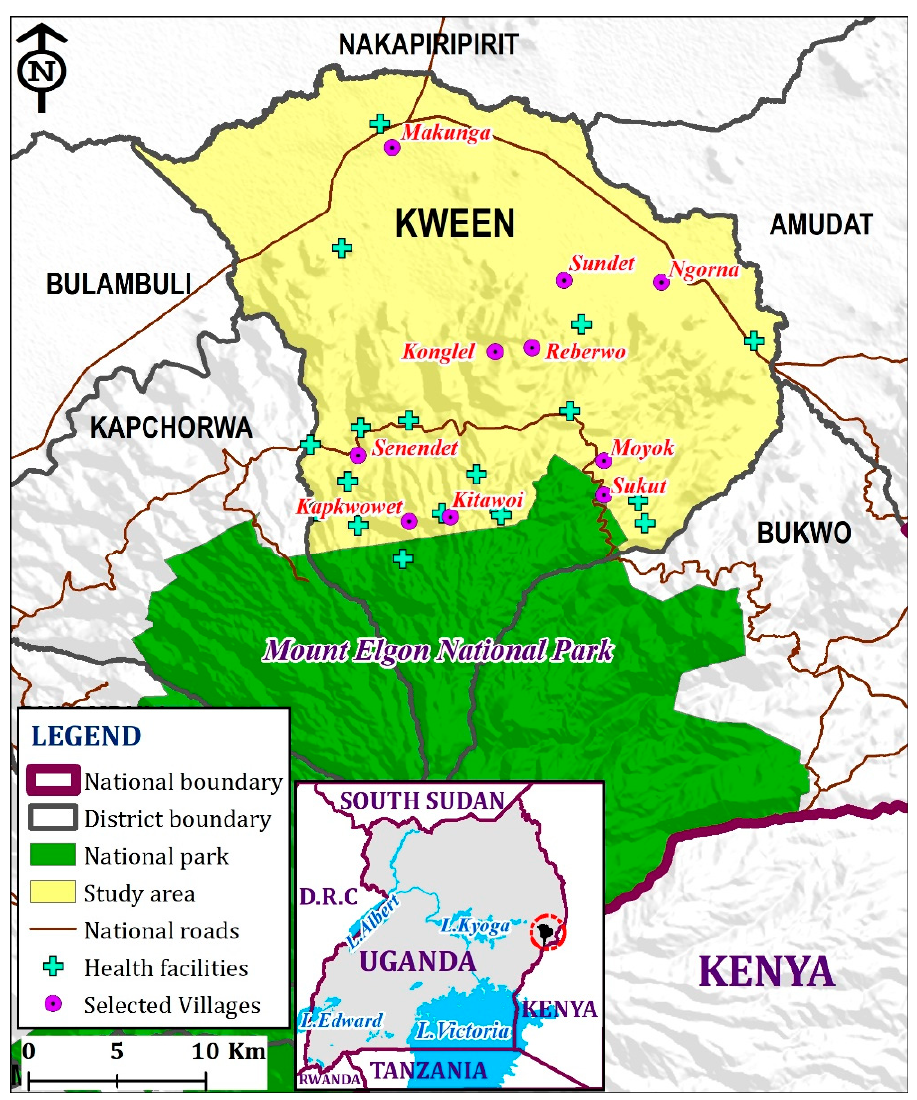
Figure 1. Location of the Kween District.